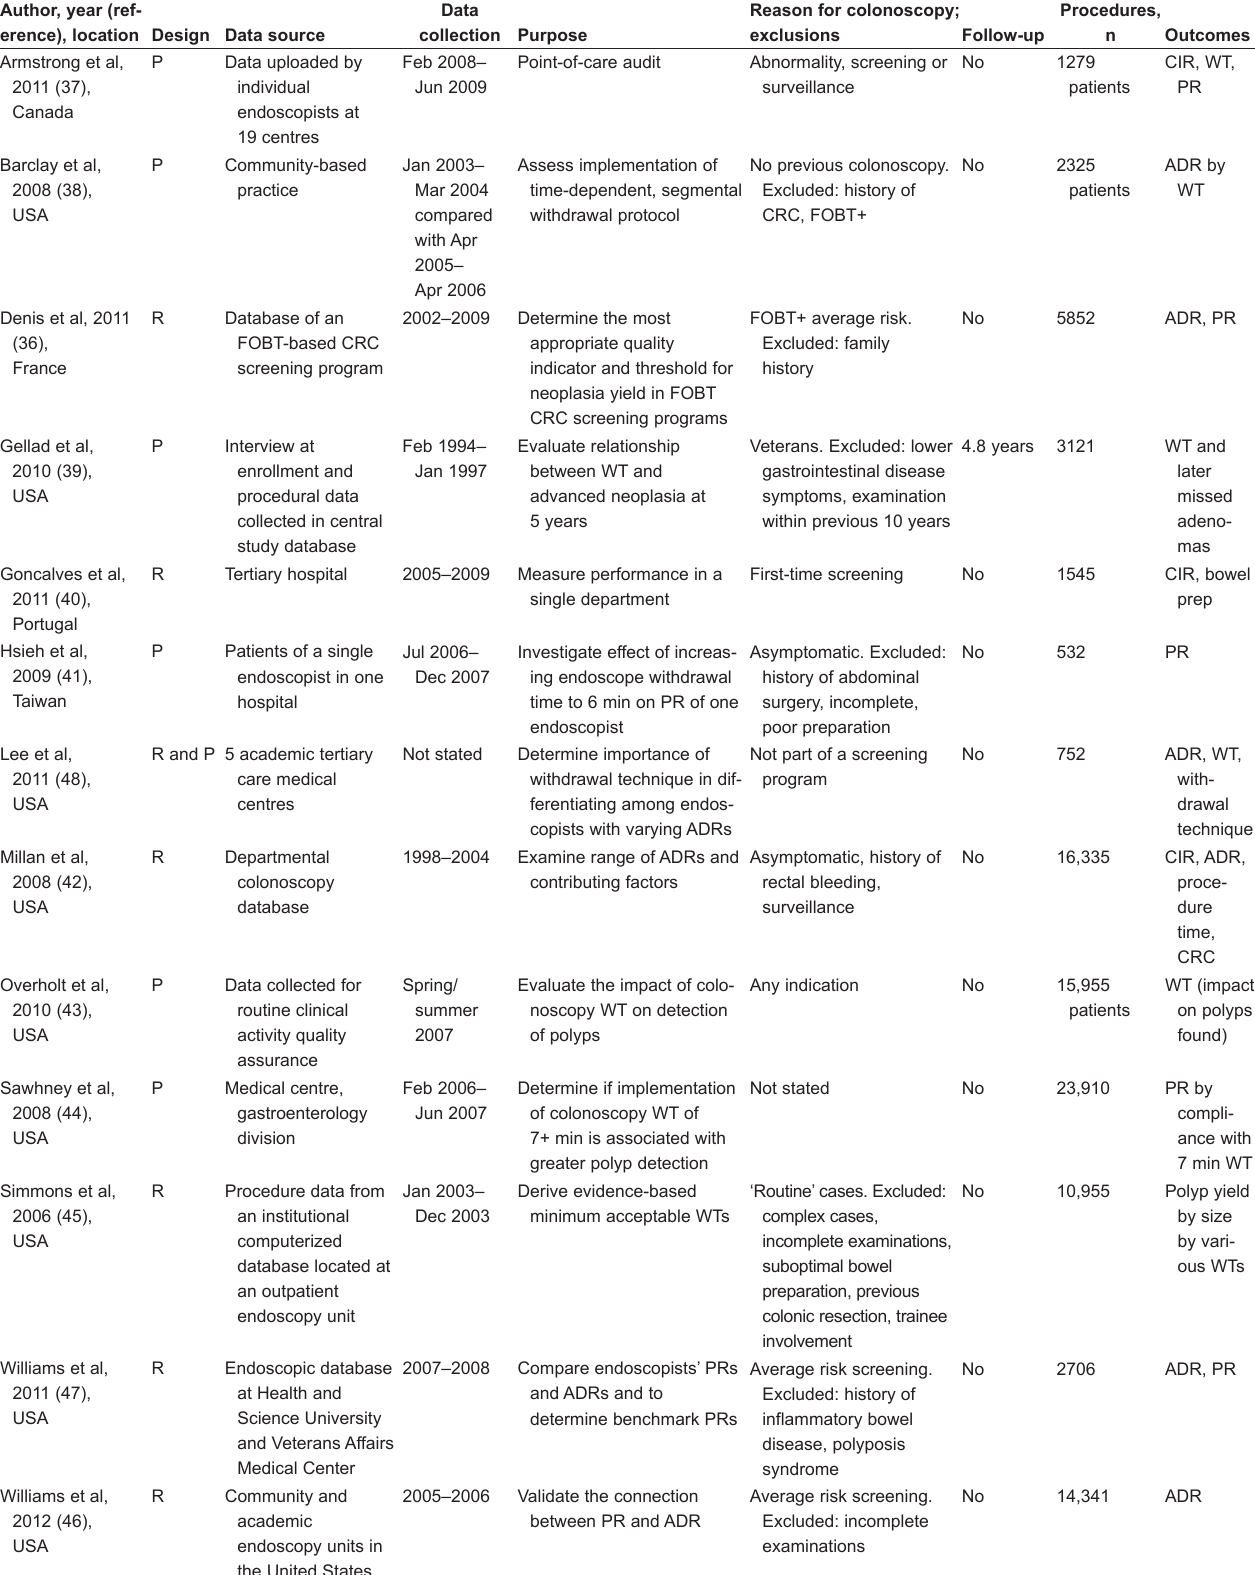
TAble 5 Characteristics of studies reporting quality indicators cecal intubation rate (CIR), adenoma detection rate